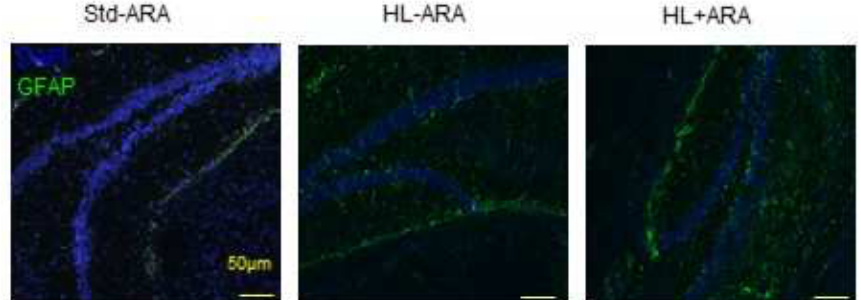
Figure 7. GFAP immunostaining (in green) in the hippocampus of mice fed the standard diet (Std- ARA) or hyperlipidic diets without arachidonic acid (HL-ARA) or with (HL + ARA) for 9 weeks. Nuclei were stained with DAPI (4’,6-diamidino-2-phenylindole, blue staining).